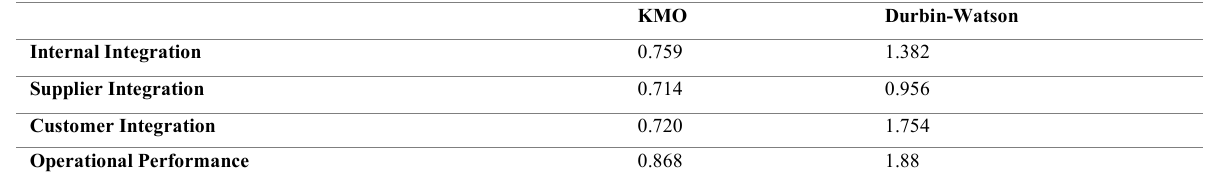
Table 2 : Statistical Analysis